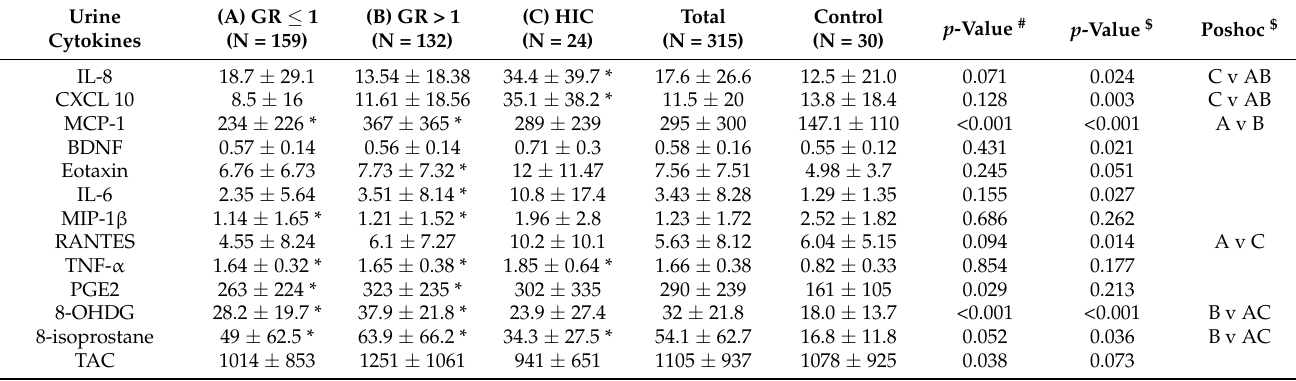
Table 3. Comparison of urine levels of biomarkers among NHIC subtypes with different grades of glomerulation and